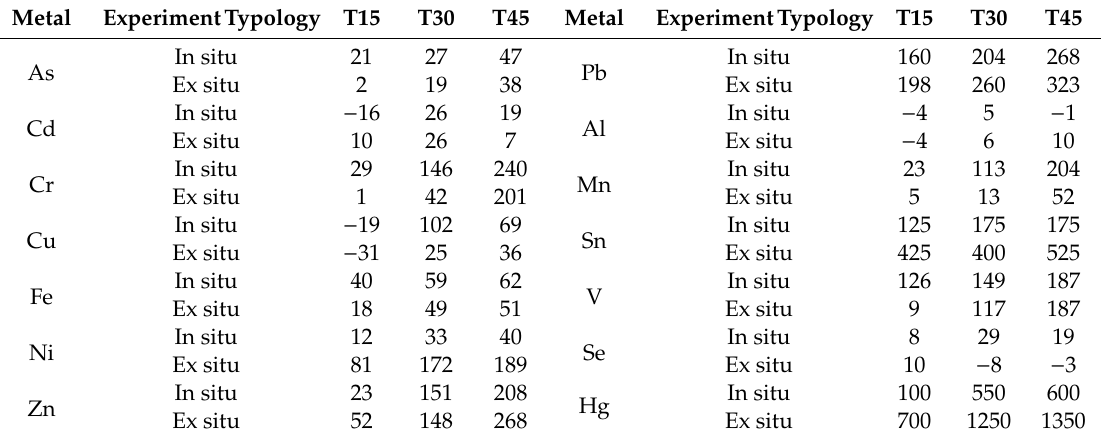
Table 4. Percentage increase (%) of metals at T15, T30, and T45 in reference to T0 for the in situ and ex situ bioaccumulation tests [31].